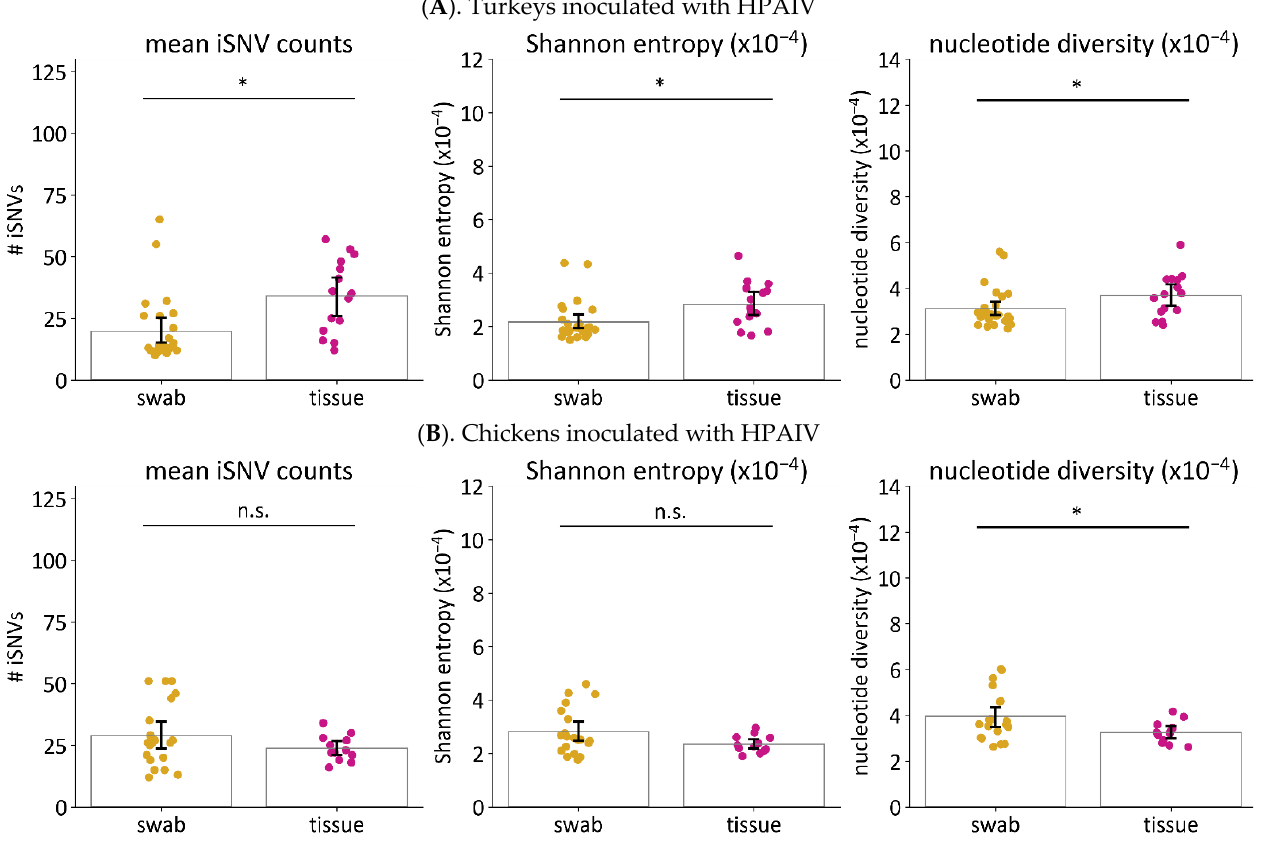
Figure 6. Comparison of iSNV diversity of H7N3 HPAIVs in tissues and swabs. The measures of iSNV diversity were calculated for OP swabs and tissue samples from directly inoculated turkeys ( A ) and chickens ( B ). The measures of iSNV diversity used are the mean iSNV count, Shannon entropy, and nucleotide diversity. Asterisks (*) indicate p < 0.05 using the Mann–Whitney test. n.s. = not significant with p ≥ 0.05.